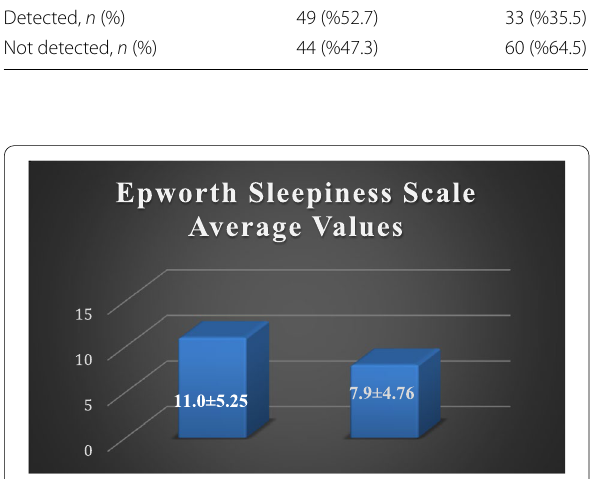
Fig. 1 ESSd (administered by the doctor) values and ESSp (self-reported by the patient) values, respectively